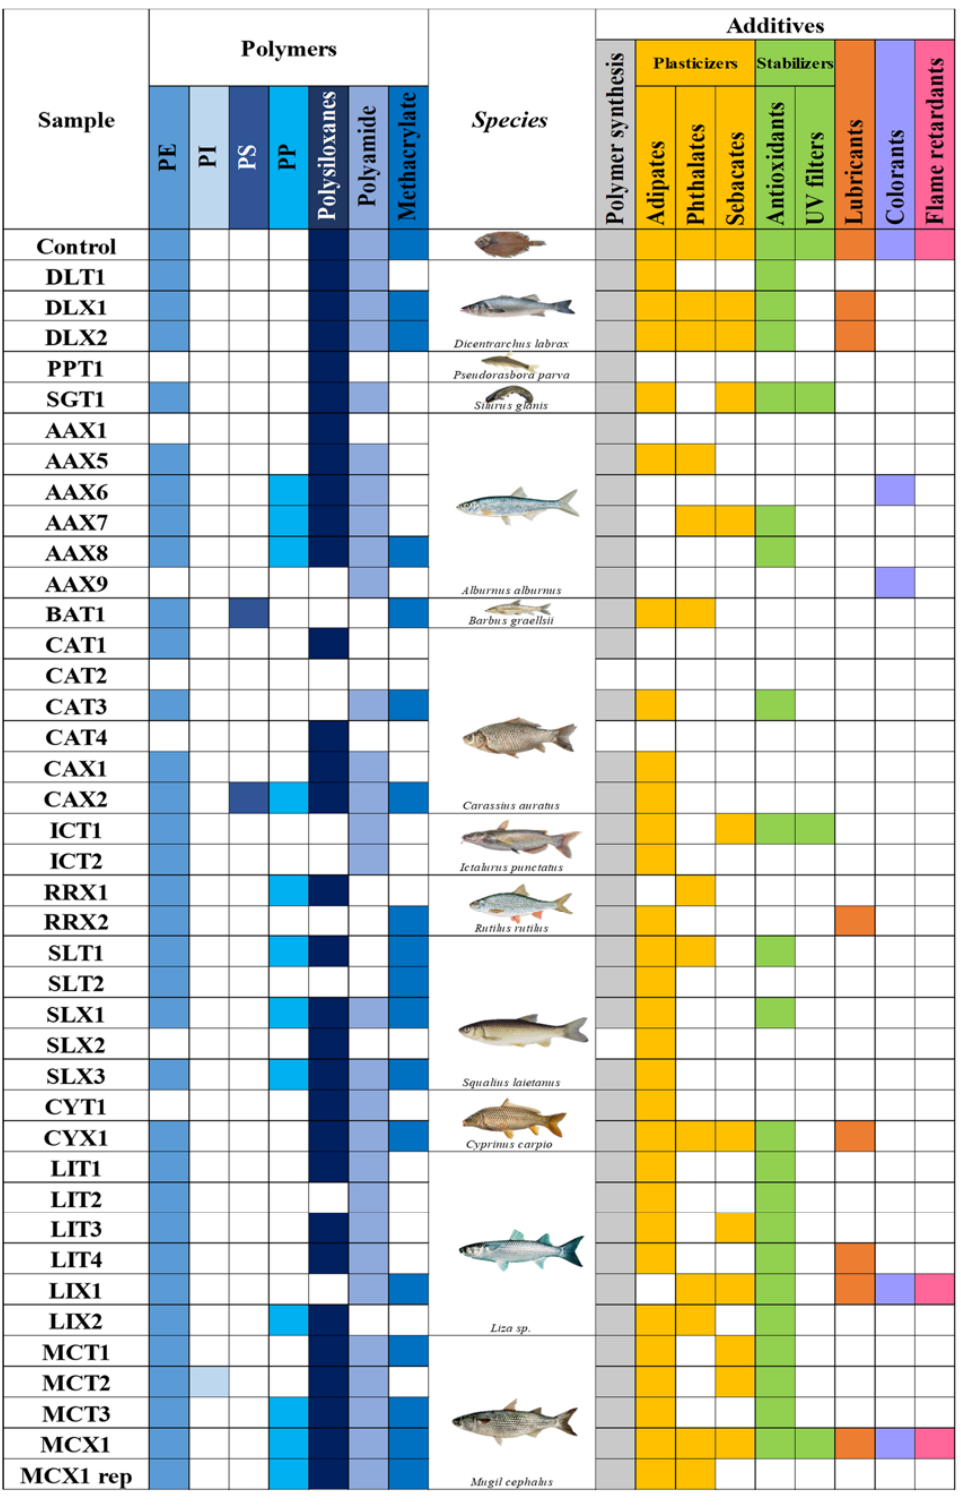
Figure 1. Summary of the polymers and plastic additive groups found in the GIT samples.